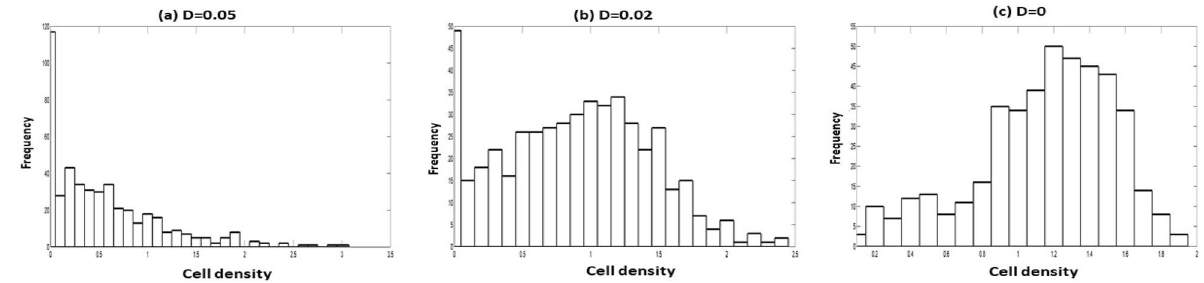
Figure 10. Distribution of cell density for r p 0.01 , and variable correlation between additive and multiplicative noises: ( a ) (cid:31) D 0.01 , Q = = 0 and ( c ) (cid:31) =